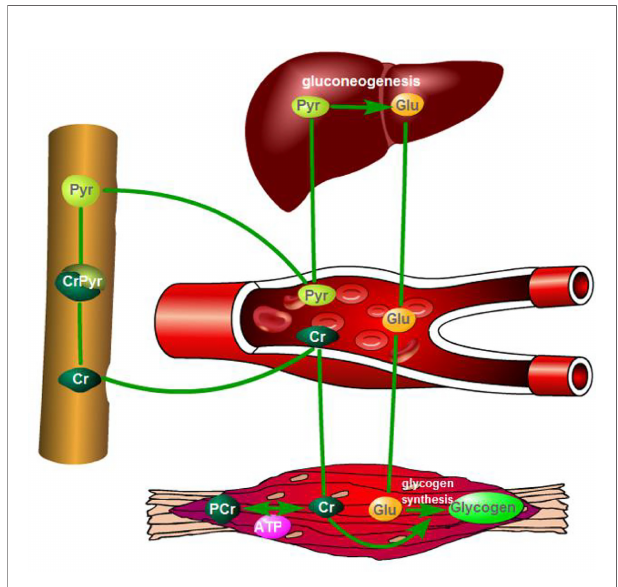
FIGURE 1 | The possible mechanisms diagram of creatine pyruvate promoting beef muscle glycogen deposit. CrPyr, creatine pyruvate; Cr, creatine; Py, pyruvate; Glu, glucose; ATP, adenosine